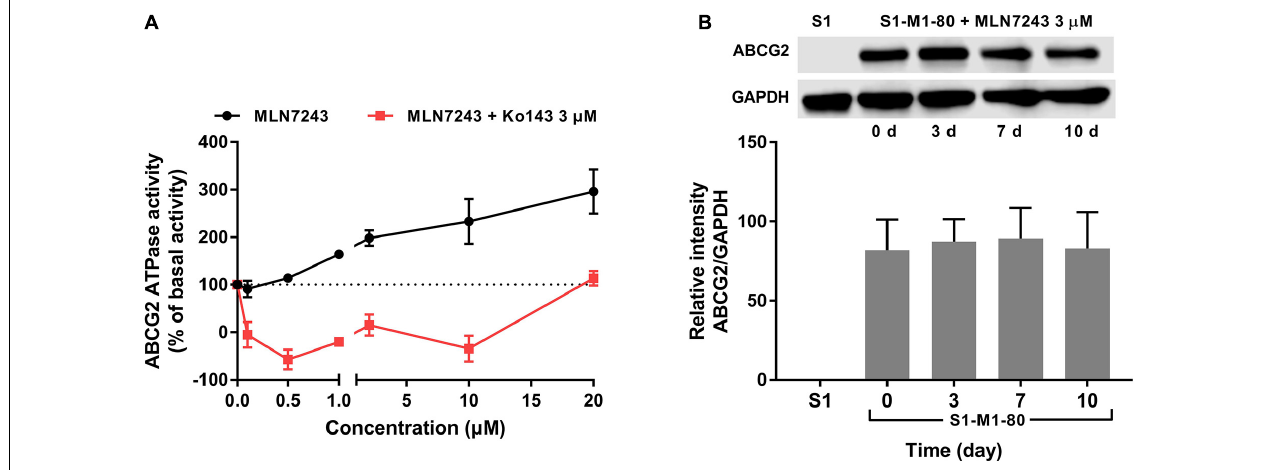
FIGURE 2 | MLN7243 stimulated ABCG2 ATPase activities without affecting to the protein expression level. (A) The effect of MLN7243 on ABCG2-mediated ATPase activity at concentration range from 0 to 20 µ M. Ko143 was used as an ABCG2 ATPase inhibitor. (B) The effect of MLN7243 on the expression level of ABCG2 in S1-M1-80 cells after 10 d treatment. Data are expressed as mean ± SD derived from three independent experiments. * p < 0.05 vs. the control group.